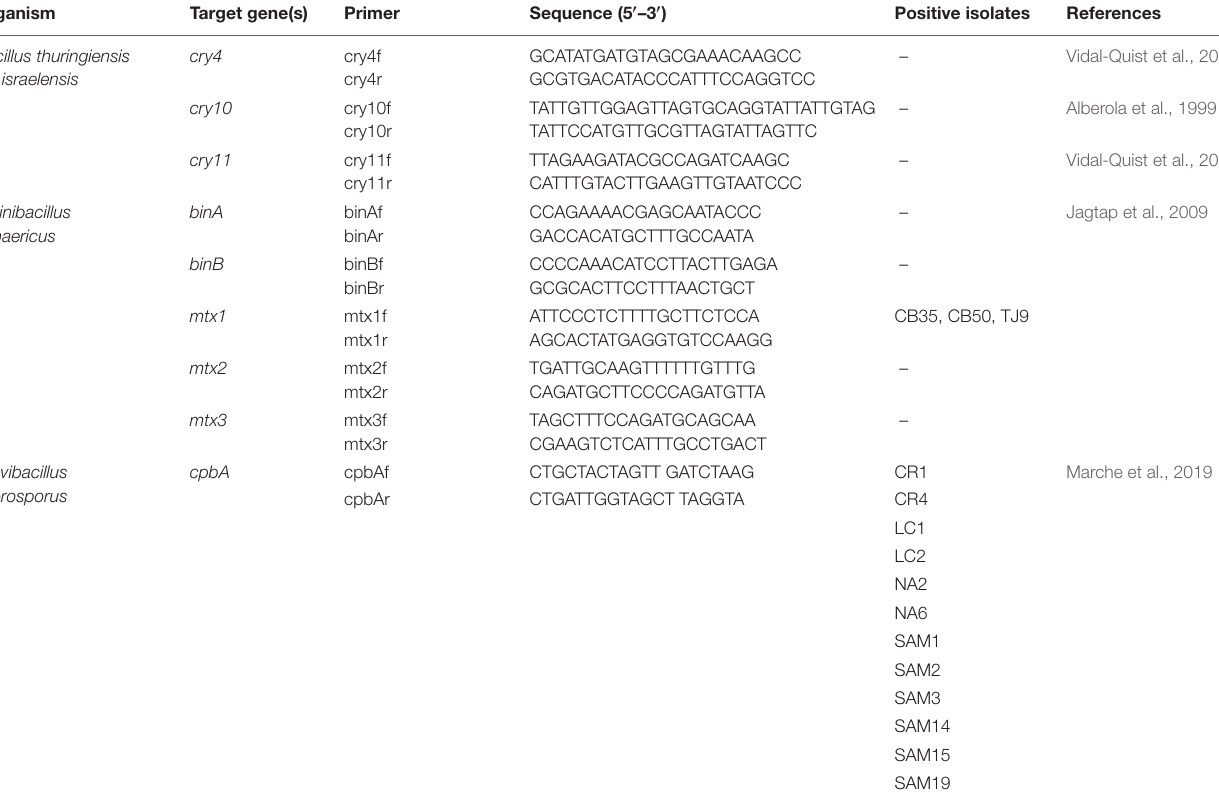
TABLE 1 | Primers used for the detection of mosquitocidal toxin genes in the isolates with larvicidal activity against Ae. albopictus .